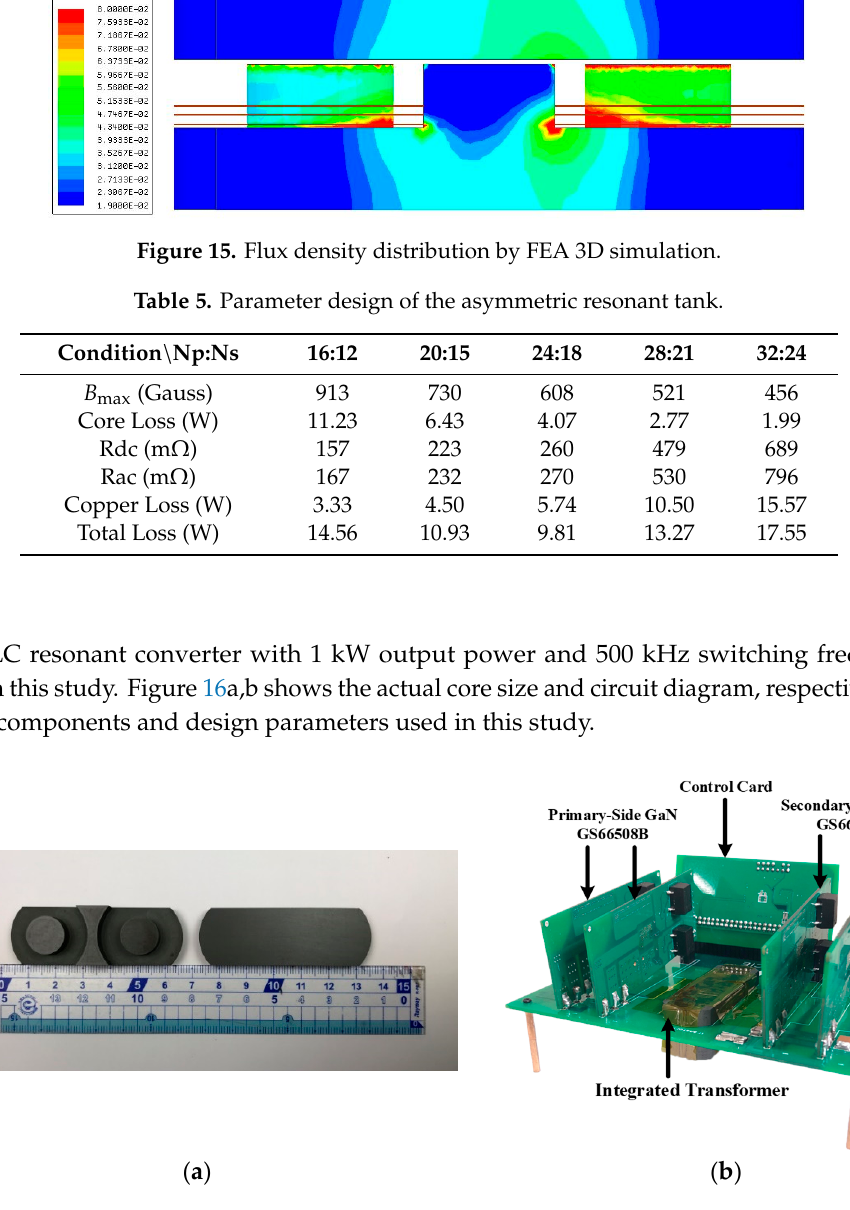
Figure 16. Experimental prototype of the ( a ) core structure and ( b ) circuit. Table 6. Parameter design of the asymmetric resonant tank.